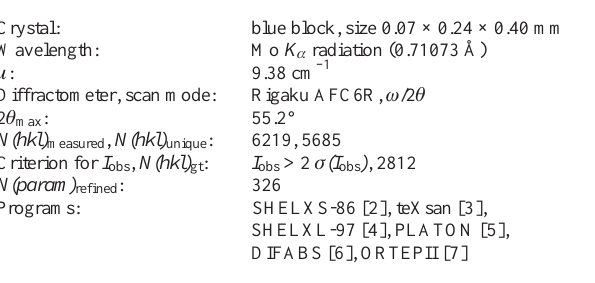
Table 1. Data collection and